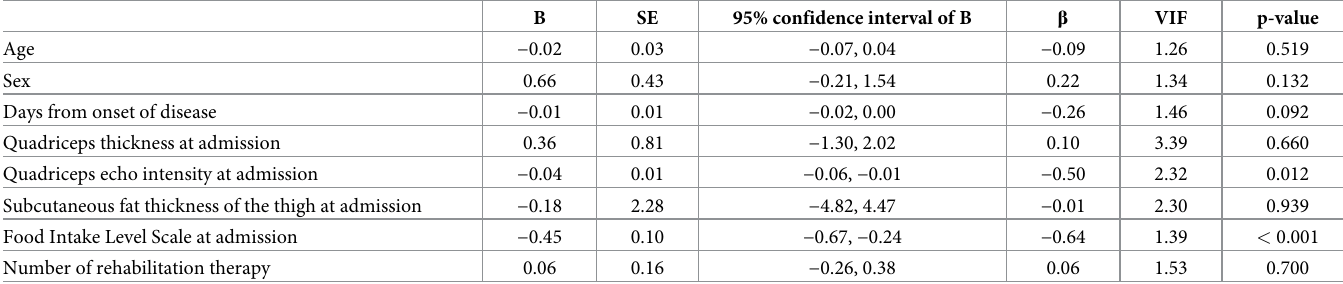
Table 4. Multiple regression analysis for change in Food Intake Level